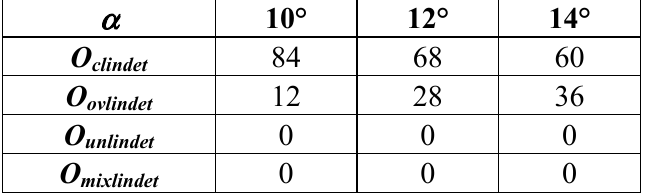
Table 2. Multi-line straight text segmentation test results.